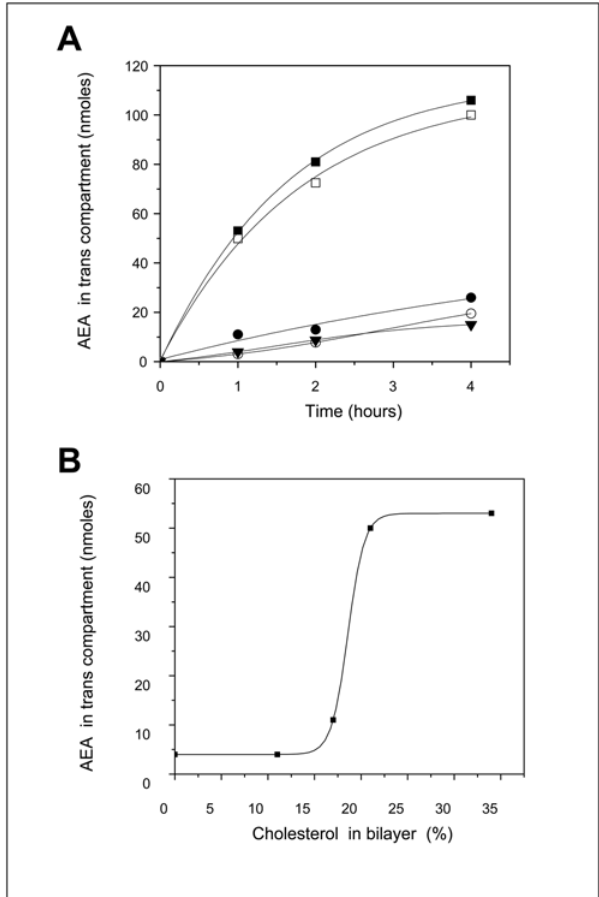
Figure 9. Kinetics of anandamide transport through planar lipid bilayers: effect of cholesterol. Planar lipid bilayers consisting of pure POPC (full triangles), or various mixtures of POPC and cholesterol [molar: molar 2:1 (full squares), 4:1 (open squares), 5:1 (full circles), 8:1 (open circles)] were obtained as described for electrical measurements. A . Anandamide (1 mM) was added to the cis compartment in presence of 4.2 mM M b CD. The amount of ananda- mide recovered in the trans compartment was enzymatically measured using an anandamide assay with 5-lipoxygenase. B . Anandamide transport as a function of cholesterol percentage in the POPC bilayer. The experimental points correspond to the amount of AEA in the trans compartment 1 hour after its addition in the cis compartment. The sigmoidal shape of the cholesterol effect suggests that a threshold level of cholesterol is required to trigger the translocation of AEA. This is consistent with the recruitment of cholesterol molecules into tail-to-tail dimers as the ordered supramolecular cholesterol structure used by AEA to cross the membrane. On the opposite, a further excess of cholesterol (full squares, panel A) would condense into non functional nanodomains unable to further increase the kinetics of AEA transport.